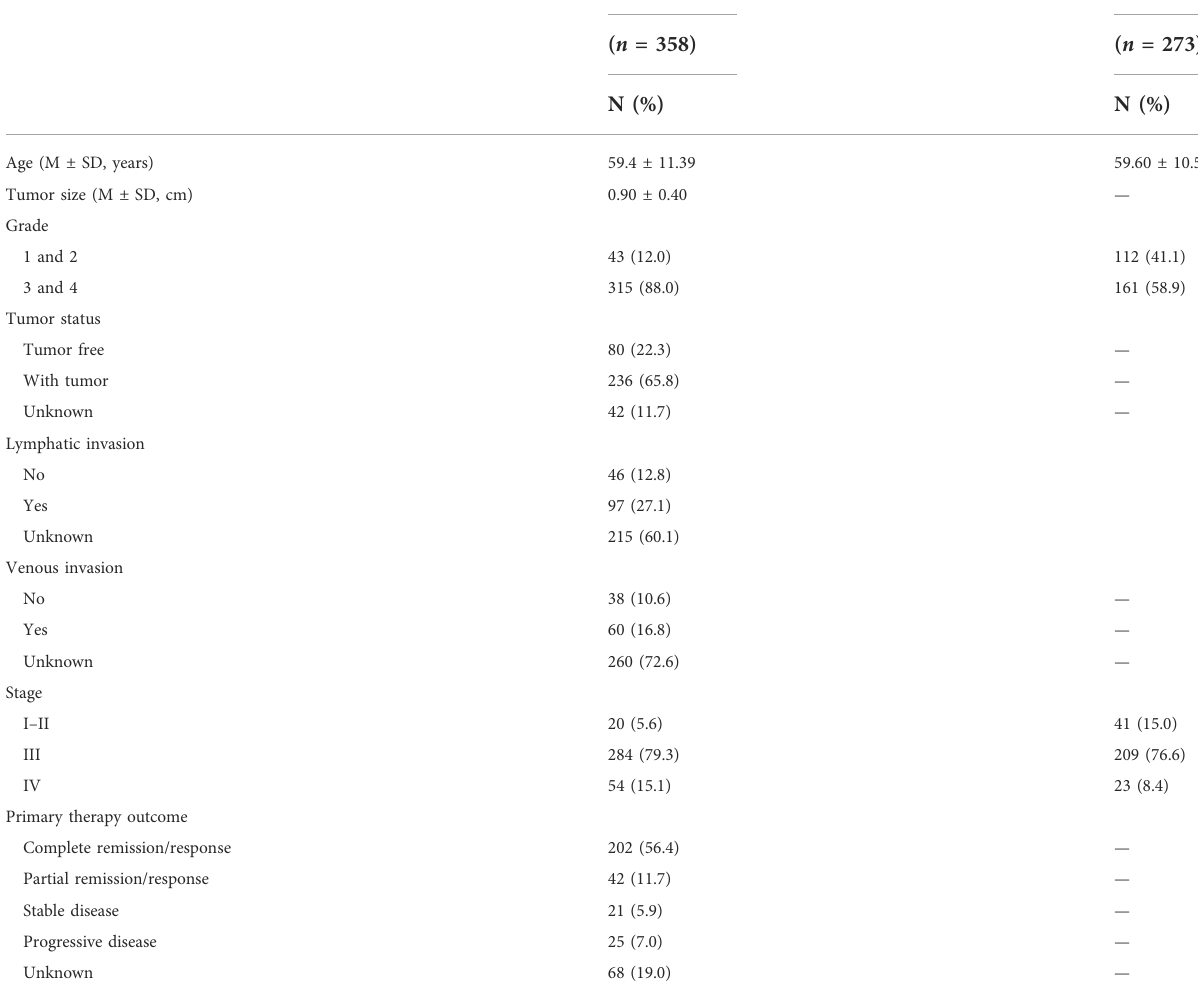
TABLE 1 Clinicopathologic characteristics of ovarian cancer (OC) patients in The Cancer Genome Atlas (TCGA) and Gene Expression Omnibus (GEO) cohorts.